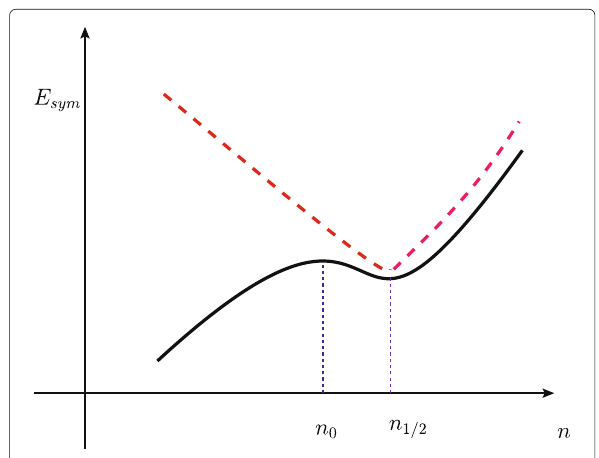
Fig. 2 Schematic illustration of the symmetry energy calculated by the skyrmion crystal (dashed line) and nucleon correlation corrections (solid